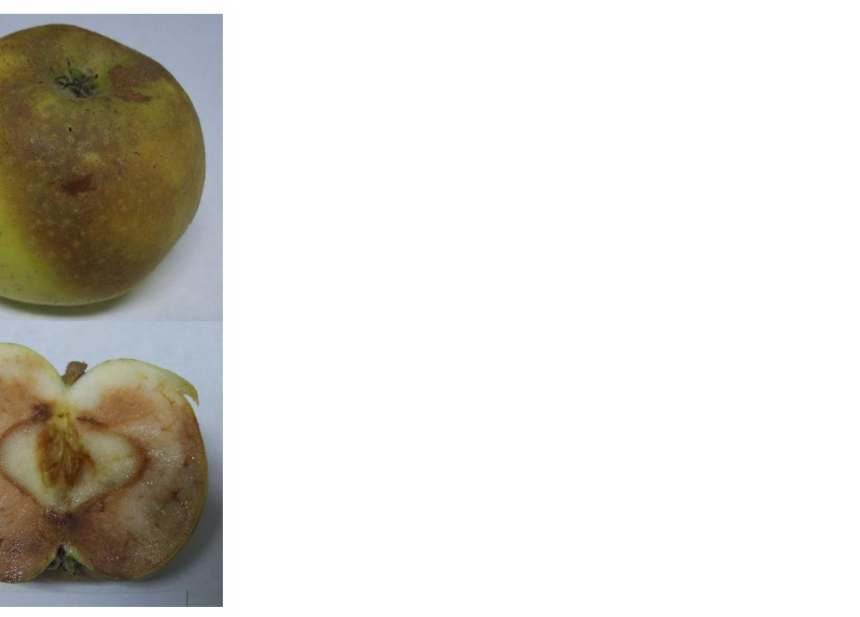
Figure 1. Senescent breakdown symptoms on apple cv. ‘Reinette du Canada’. ( A ) Skin symptom. ( B ) Flesh